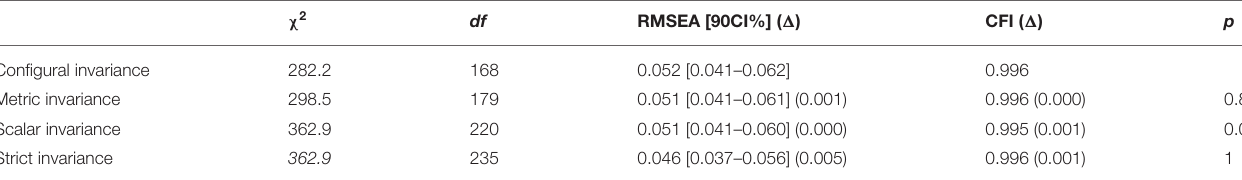
TABLE 3 | Multiple-group confirmatory factor analysis models for measurement and structure invariance across